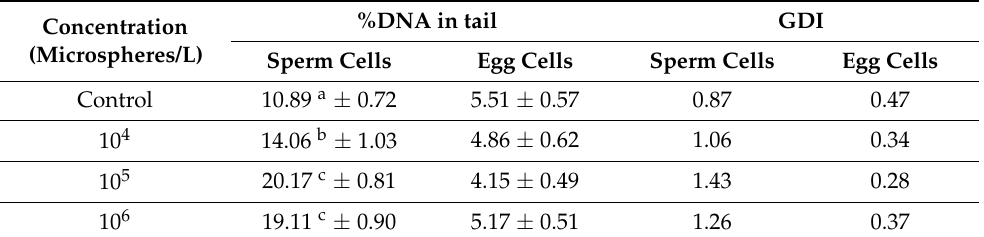
Table 1. Assessment of DNA damage (mean ± standard deviation, N = 16; n = 800).